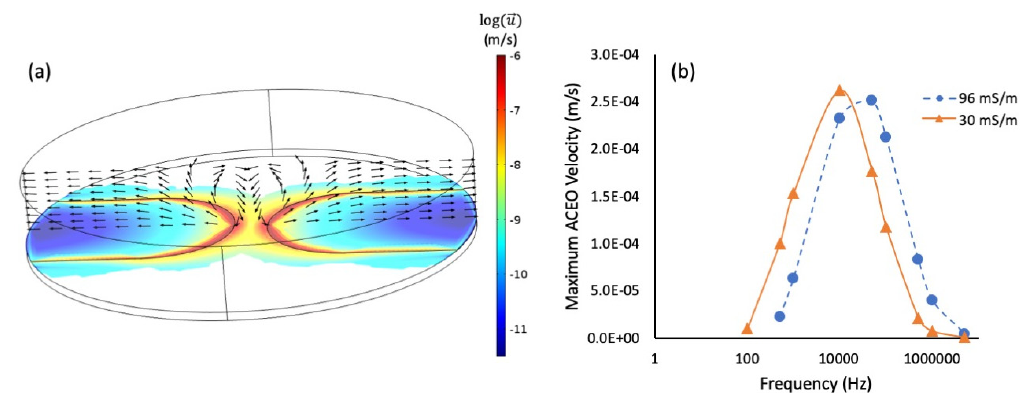
Figure 3. COMSOL simulation of AC electroosmotic flow. ( a ) Simulation results at 100 kHz, 30 mS / m medium conductivity. The image has been tilted for visualization. Bipolar electrodes with the same interelectrode spacing (40 µ m) were chosen for simplicity. In the plane of the microelectrodes, the color legend indicates the magnitude of the electroosmotic velocity. The arrows perpendicular to the electrode plane indicate the direction of the AC electroosmotic velocity. ( b ) The maximum AC electroosmotic velocity at varying AC frequency and medium conductivity. Each point in these curves represents the maximum AC electroosmotic velocity obtained from a single independent COMSOL simulation. The conductivity of the IH-AuNPs is approximately 96 mS / m (above the established conductivity threshold), and 30 mS / m approximates that of the C-AuNPs (below the established conductivity threshold).